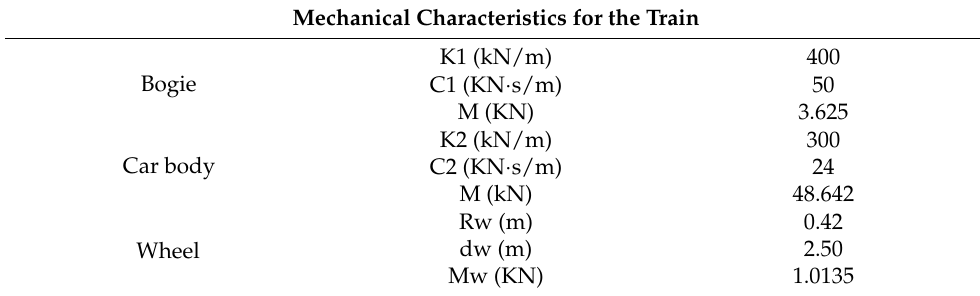
Figure 2 . Simplified model. Train model ( left ). Couple model of train and track as a combination of springs and dumpers ( right ). Table 2. Mechanical properties of the train used in the simulation.